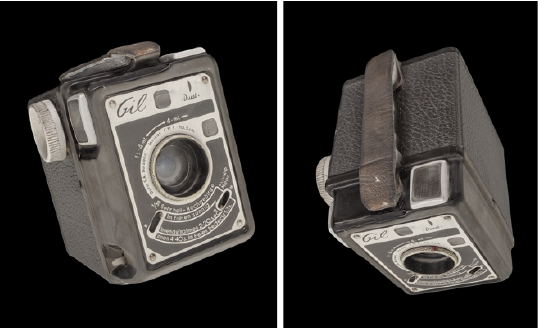
Figure 12: Views of a 3D model of the 1938 Durst Gil camera reconstructed from two shots taken at different object poses.